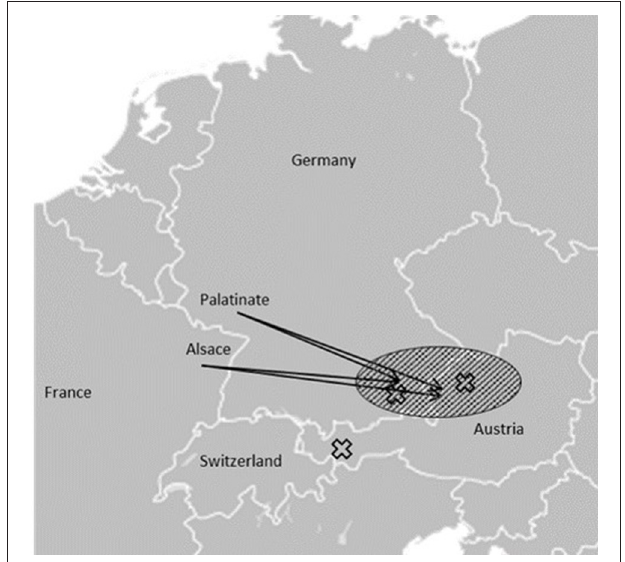
FIGURE 3 | Schematic representation: Amish movements from the Palatinate and Alsace regions to Bavaria and Upper Austria in the late eighteenth and early nineteenth centuries are marked with arrows and a dashed field. The origins of the reported families are marked with X, families II and III originated from within the area of Amish settlements (Figure is based on "Blank map of Europe.svg” by Maix which is licensed under CC BY-SA